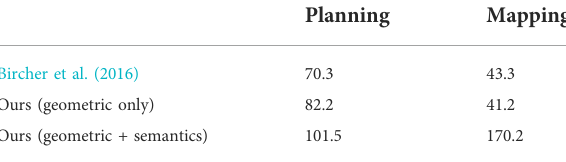
TABLE 7 Average computational times (ms) per iteration